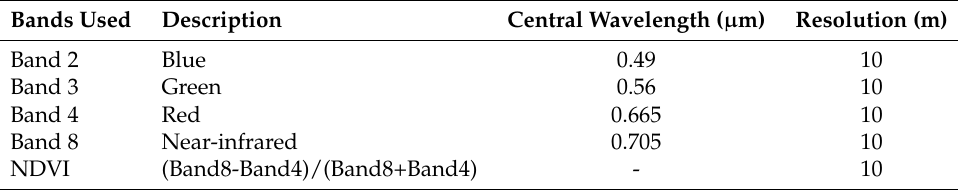
Table 1. Bands used in this study.